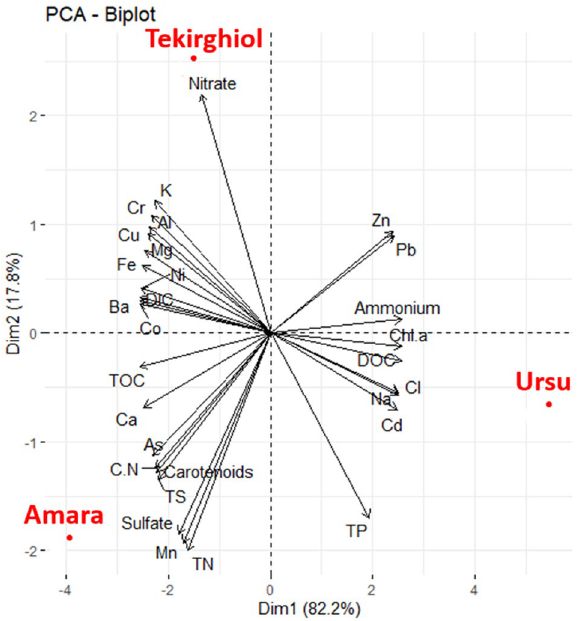
Figure 5. PCA (Principal component analysis) plot indicating the main physicochemical parameters that contribute to sapropel